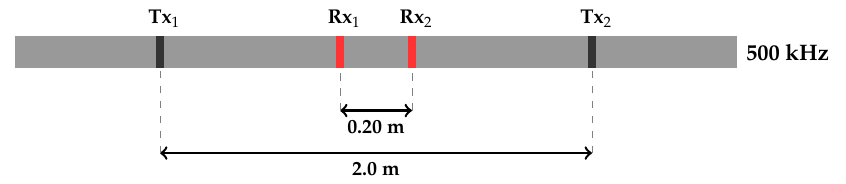
Figure 10. Logging instrument for model problem 2. Tx 1 and Tx 2 are the induction transmitters, and Rx 1 and Rx 2 are the